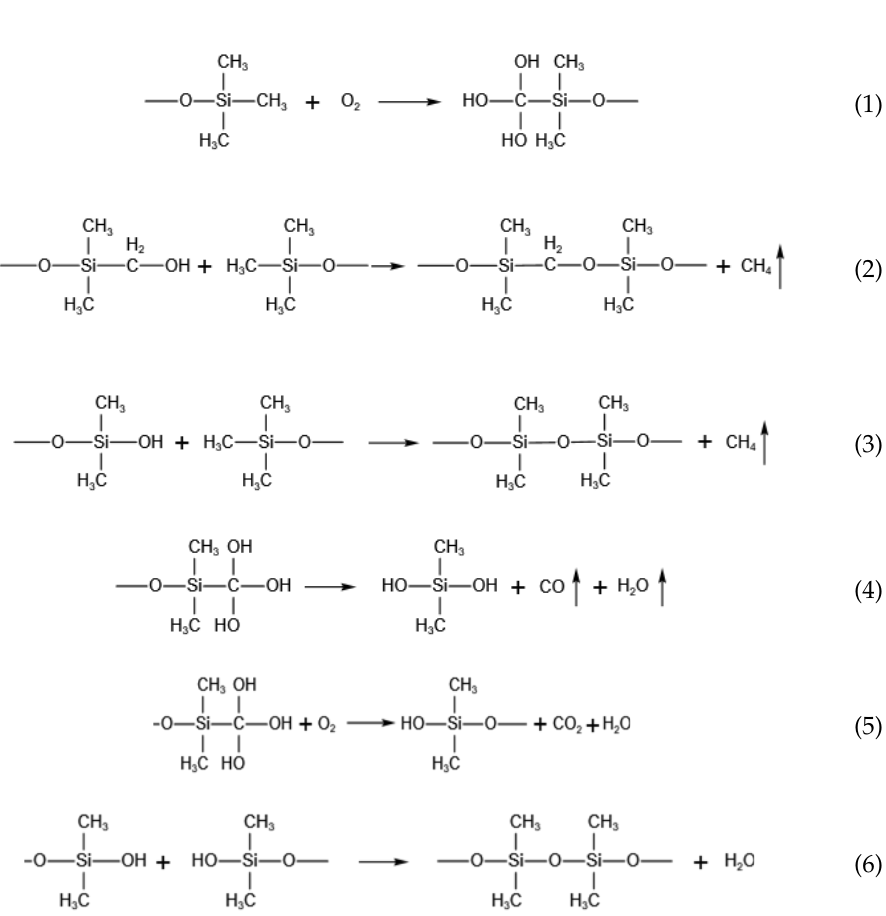
Figure 6. TG-IR spectra of the untreated silica aerogel under ( a ) air and ( b ) N 2 . ( c ) SVUV-PIMS of background and signal intensity trends of m/z = 18 and 32. ( d ) SVUV-PIMS at 450 °C and signal intensity trends of m/z = 16 and 28.